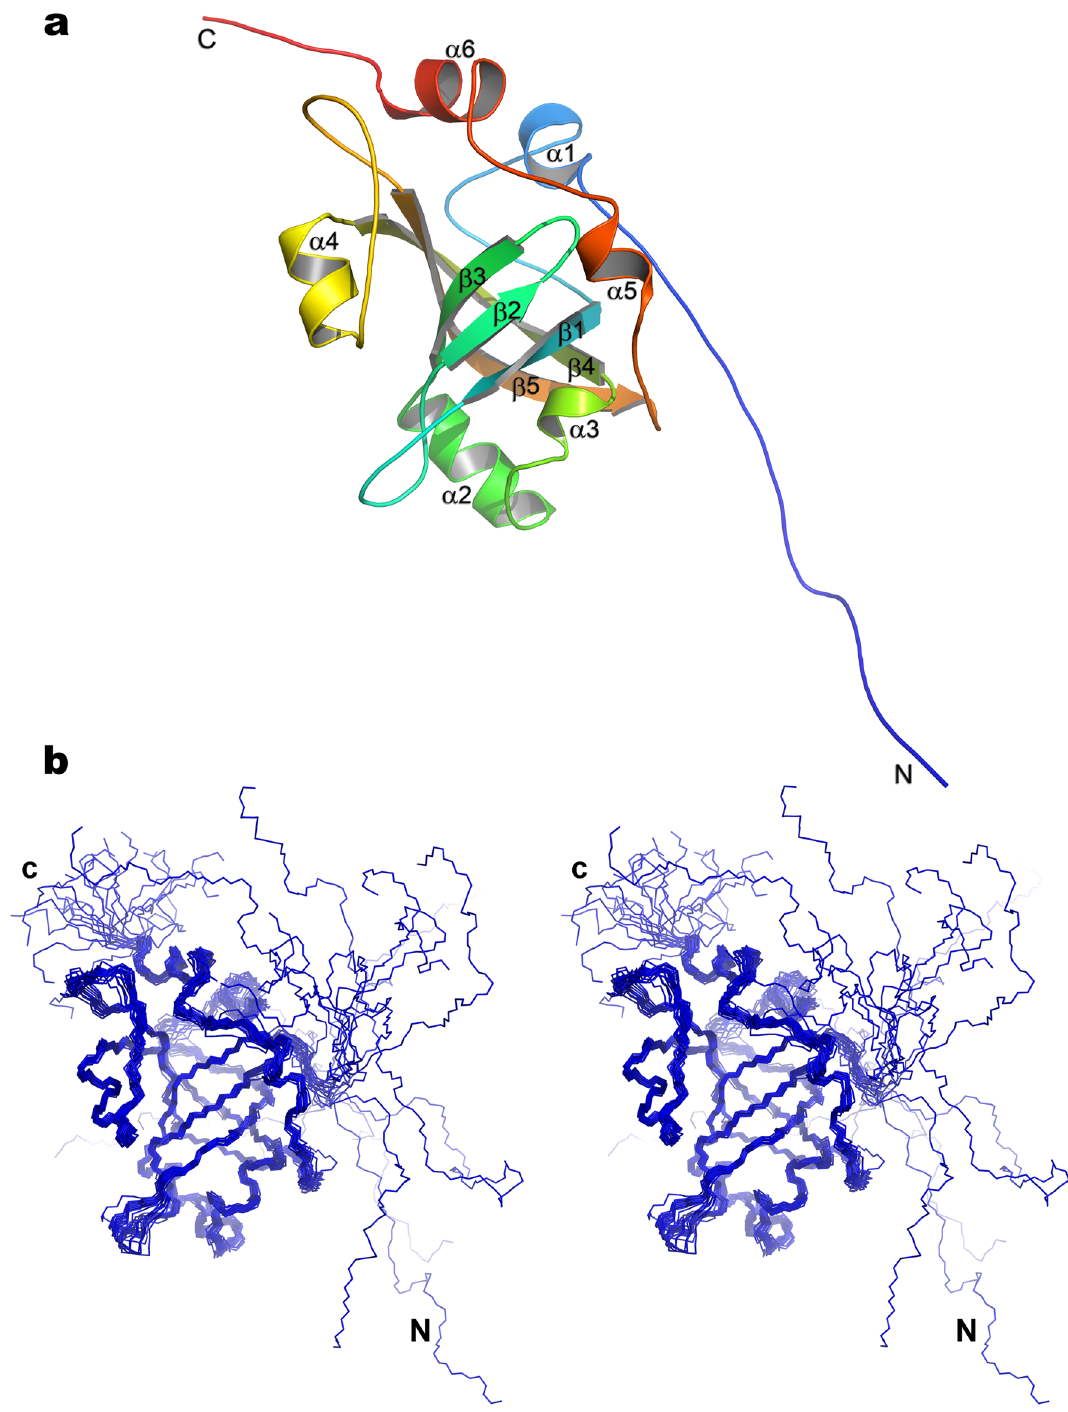
Figure 3. The solution structure of the HpEst3. ( a ) The topology of the secondary structure elements of the HpEst3 protein. ( b ) The stereo view of the ensemble of the final 20 calculated structures. Images were made using PyMOL v. 2.3 (Schrodinger,